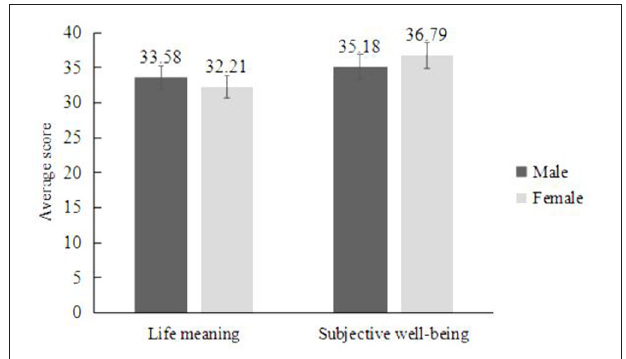
FIGURE 1 | Comparison of differences between the life meaning and subjective well-being of older person of different genders. Gender differences existed in the respondents’ perception of life meaning but not in the subjective well-being: men had a better perception of life meaning. The data on the bar chart are averages, and the vertical line represents the standard error.